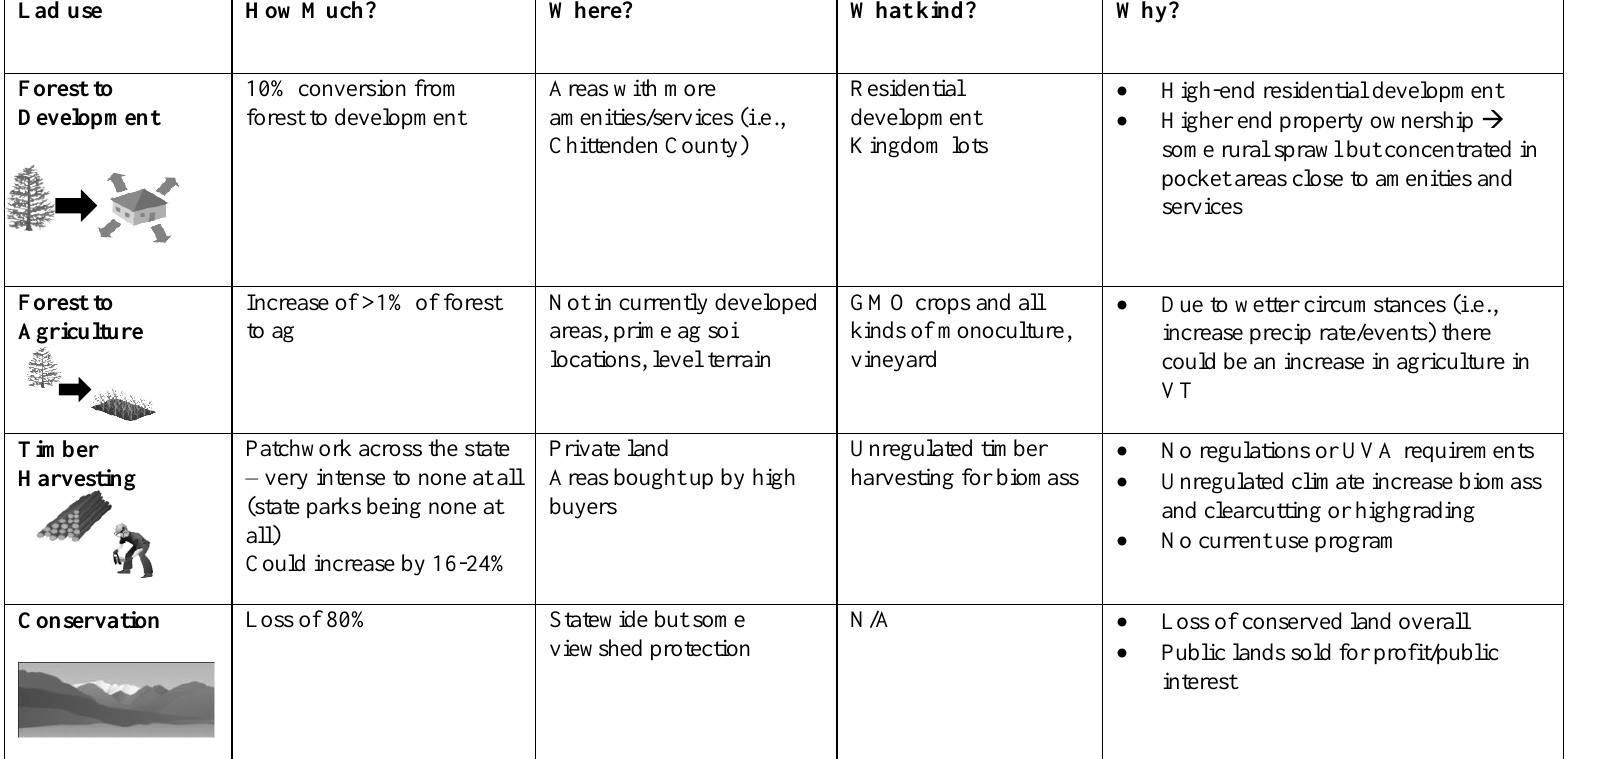
Table A2.4. Scenario 4: Post It If You Can Lad